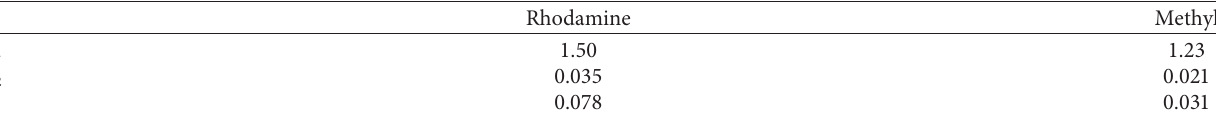
Table 7: A table of pseudo-second-order kinetics for the degradation of rhodamine blue and methyl